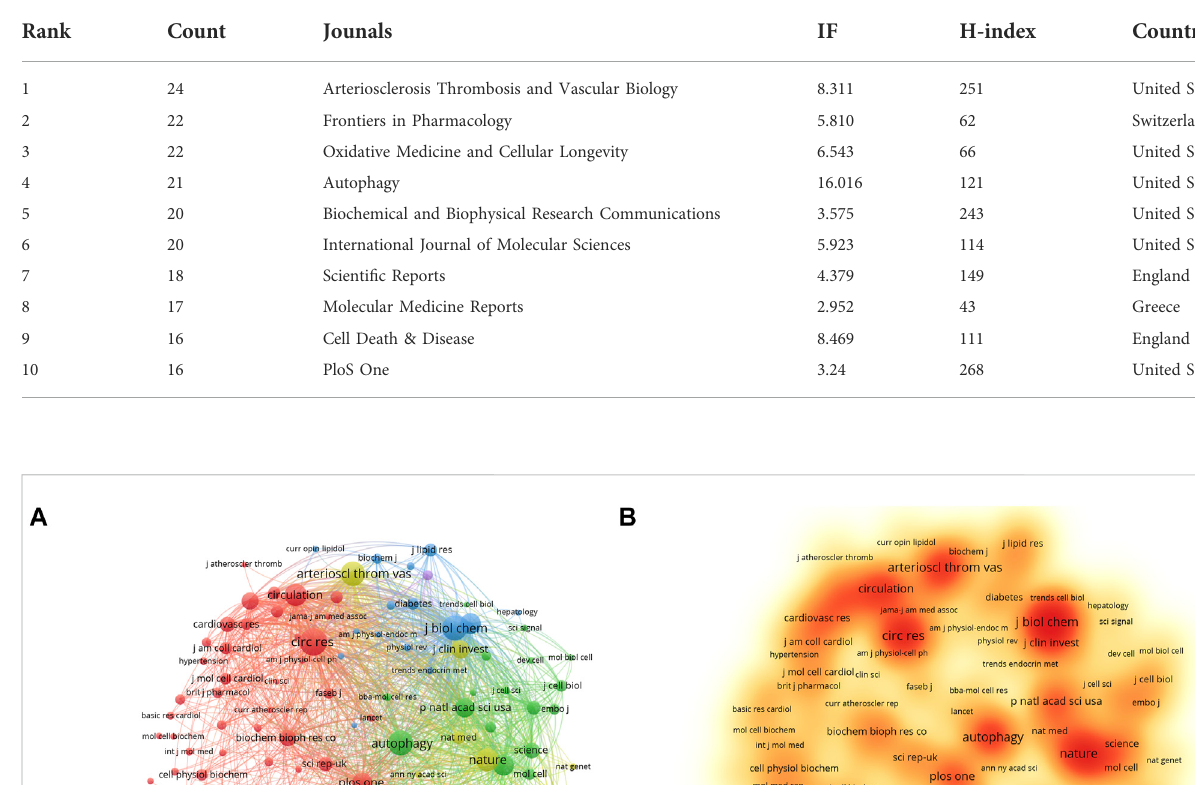
TABLE 4 Top 10 journals with most publications.